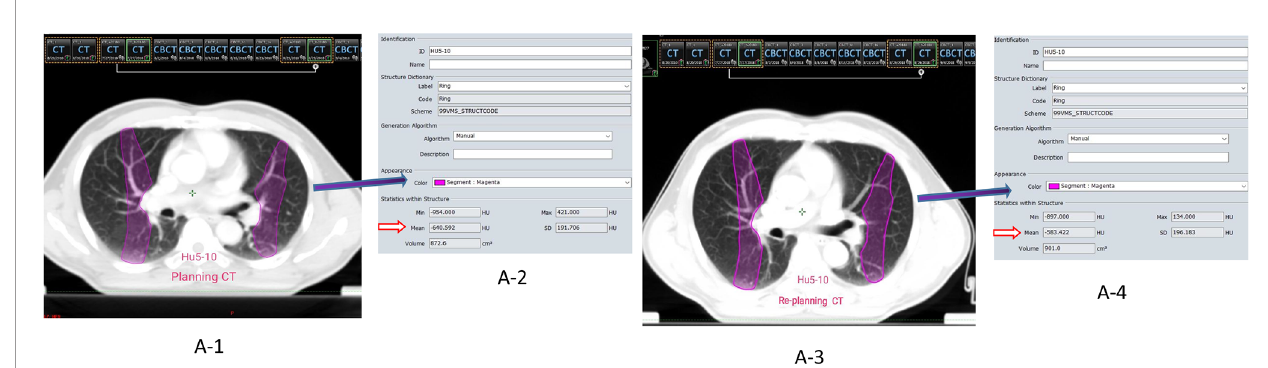
FIGURE 1 | (A 1-4 ) The dose gradient interval of HU 5-10 was selected as an example. ① A-1/A-3 represent the images of the planning CT and the re-planning respectively (Rigid Registration); ② A-2/A-4 represent the parameters of the gradient interval of HU 5-10 , respectively (Mean**HU: mean density value); ③ Calculation of density difference ( D HU) = Planning CT (HU mean ) − Replanning (HU mean